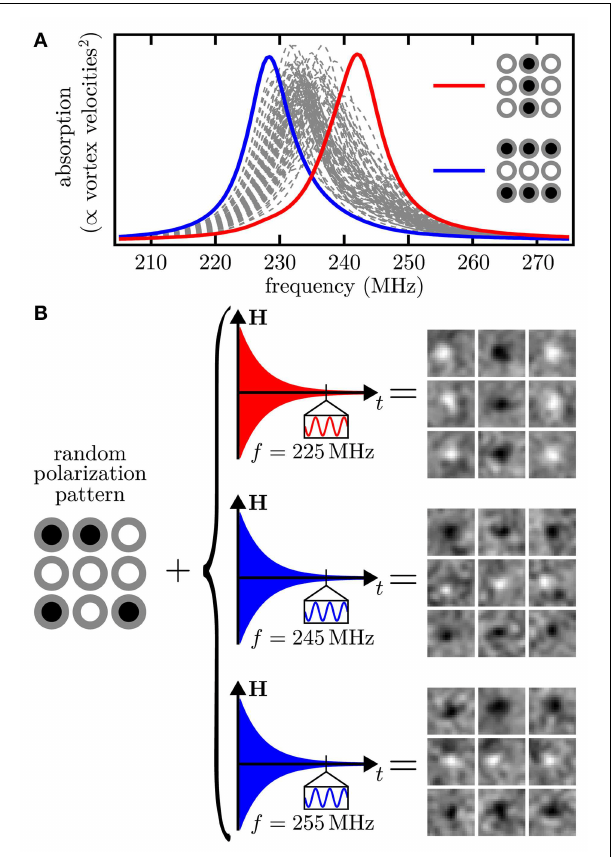
FIGURE 6 | (A) Vortex arrays investigated with transmission soft X-ray microscopy. The magnetic field H is applied via an alternating current send through a coplanar waveguide. The disks have a diameter of 2 µ m and a center-to-center distance of 3 µ m. The thickness of the disks is 60nm. (B) Calculated eigenfrequencies of the polarization pattern with columns of alternating polarization. (C) Trajectories of the eigenmodes. Phase relations of the depicted snapshot are indicated by black dots. The polarization is color-coded (red and blue for up and down) to indicate the sense of rotation.